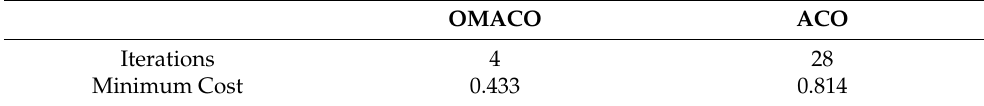
Table 4. Solution comparison between OMACO and ACO.